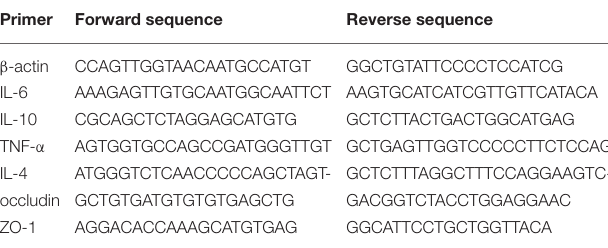
TABLE 1 | Animal experimental protocol. Group